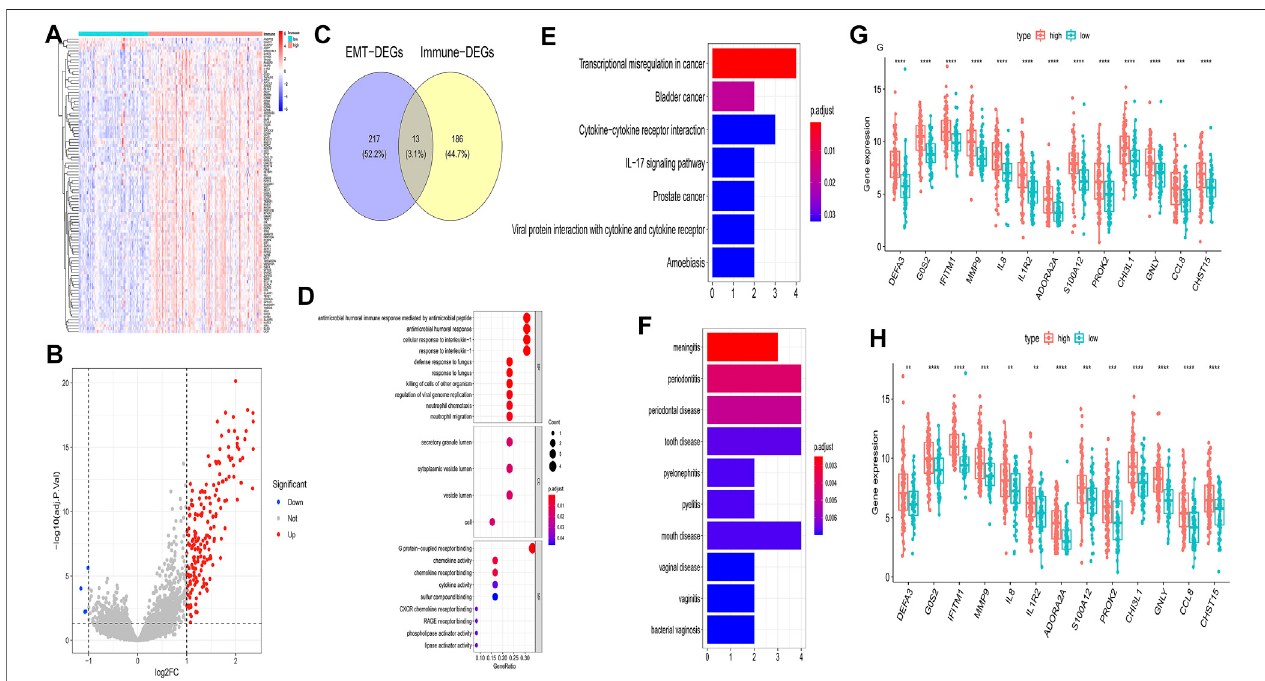
FIGURE 4 | Identi fi cation of EMT- and immune-related genes and functional enrichment analysis in the training set. (A) Heatmap of DEGs between patients of the immune score-high group and patients of the immune score-low group. (B) Volcano plot of DEGs between patients of the immune score-high group and patients of the immune score-low group. (C) Venn diagram to identify EMT- and immune-related genes (D) GO enrichment analysis of EMT- and immune-related genes. (E) KEGG enrichment analysis of EMT- and immune-related genes. (F) DO enrichment analysis of EMT- and immune-related genes. (G) Differences of 13 genes in G-GSE70866 between high- and low-EMT score groups. (H) Differences of 13 genes in H-GSE70866 between high- and low-immune score